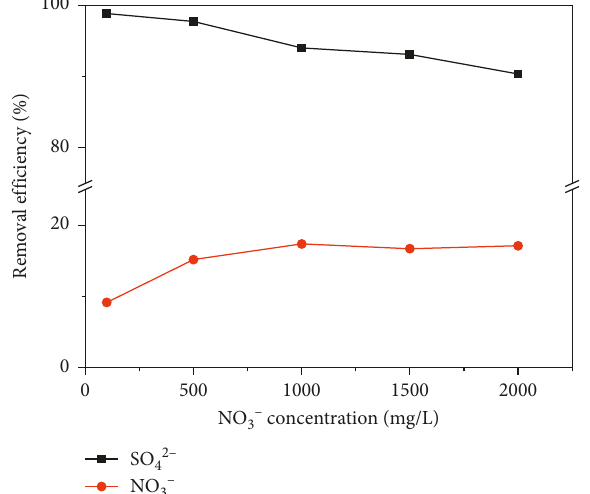
Figure 8: The effect of NO Al :S) 4:1:1, v (cid:27)